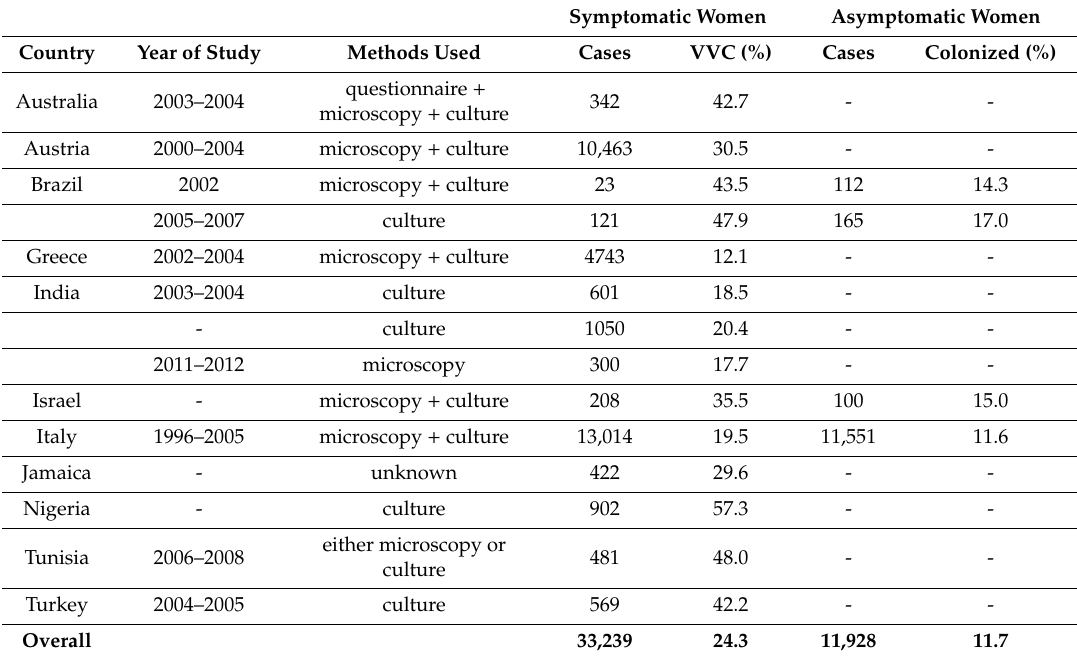
Table 1. Vulvovaginal candidosis (VVC) and Candida colonization in di ff erent countries—adapted from Gonçalves et al.